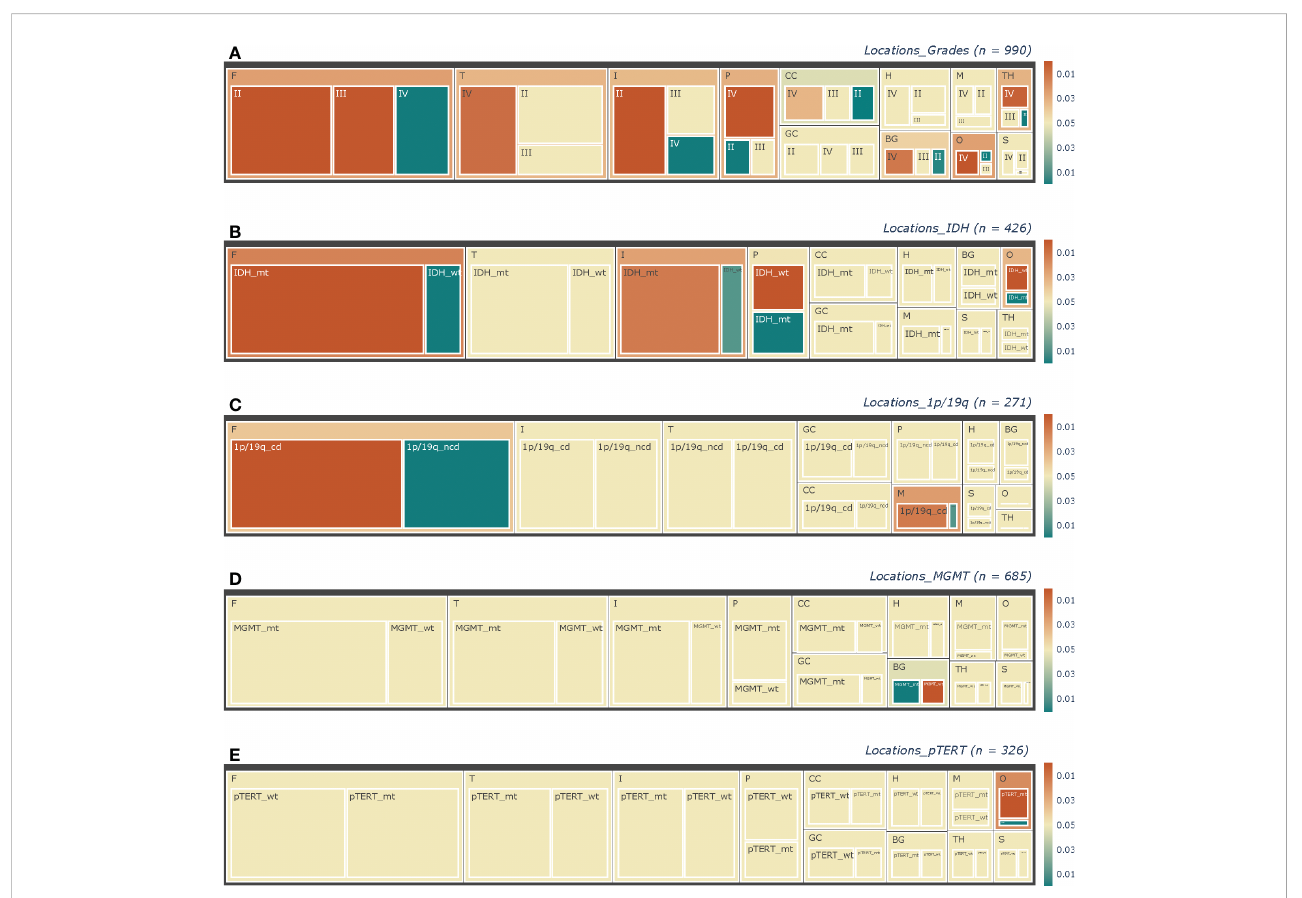
FIGURE 3 Tree-maps of the pathological constitutions. Constitutions of (A) Grade, (B) IDH status, (C) 1p/19q status, (D) MGMT status, and (E) pTERT in each anatomic area are respectively shown in diagrams. The lateral factors were not concerned here. Each block represents a subgroup in corresponding hierarchies, with block size showing the ratio of its sample size to the counterpart. The total sample sizes in each chart are noted at the upper right as “ (n =) ” . As shown in the color bars at the right parts, the color of blocks represented the p-value revealed by chi-square tests, with the yellow color representing those insigni fi cant results of p > = 0.05, while the red and green colors mean “ greater ” and “ less ” separately. In addition, the deeper the color is, the smaller the p-value will be. F, Frontal lobes; T, Temporal lobes; P, Parietal lobes; O, Occipital lobes; CC, Corpora Callosa; BG, Basal Ganglia; TH, Thalami; M, Motor regions; S, Sensory regions; H, Hippocampi; GC, Gyri Cinguli; IDH_mt, IDH_mutant type; IDH_wt, IDH_wild type; 1p/19q_cd, 1p/19q_codeleted; 1p/19q_ncd, 1p/19q_nodeleted; MGMT_wt, MGMT_methylated; MGMT_wt, MGMT_wild type; pTERT_mt, pTERT_ mutant type; pTERT_wt, pTERT_ wild